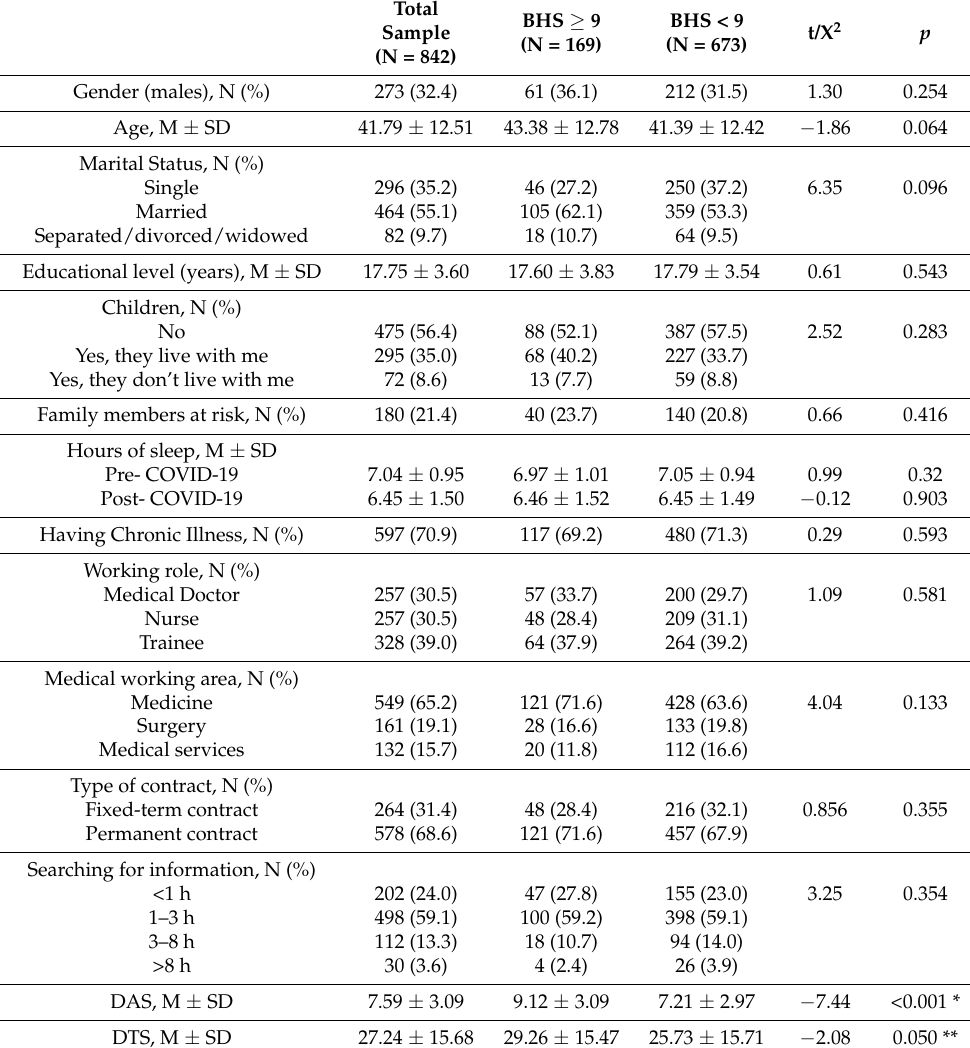
Table 1. Socio-demographic and working characteristics of the total sample, and comparison of the two subgroups based on the presence of